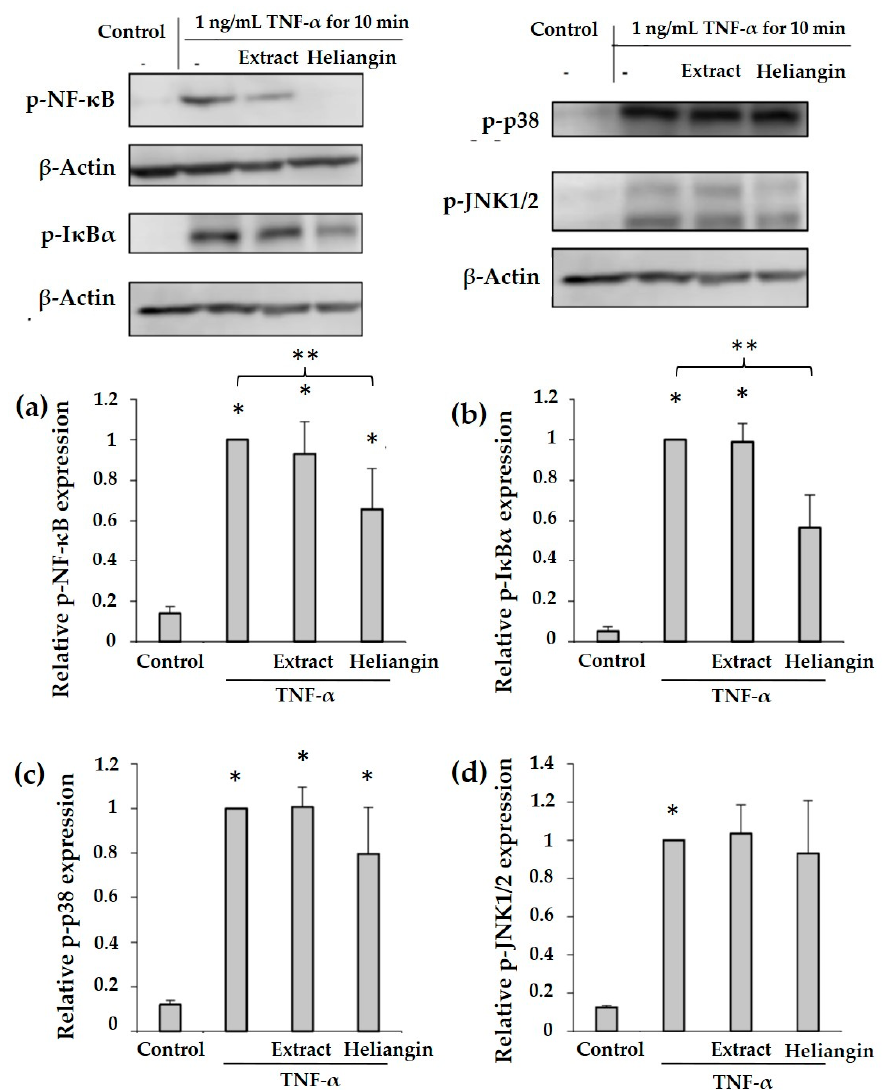
Figure 4. Ability of heliangin to inhibit NF- κ B and MAPK pathway activation in VECs. Vascular endothelial cells were consecutively incubated with 200 µ g/mL of crude ethanol extract (Extract) or 15 µ M heliangin for 24 h and then 1 ng/mL TNF- α for 10 min. Relative protein expressions of ( a ) p-NF- κ B, ( b ) p-I κ B α , ( c ) p-p38 MAPK (p-p38), and ( d ) p-JNK1/2 were analyzed by Western blotting. Values are shown as the mean ± SD ( n = 4); p < 0.05 vs. * control and ** TNF- α (ANOVA with Tukey’s